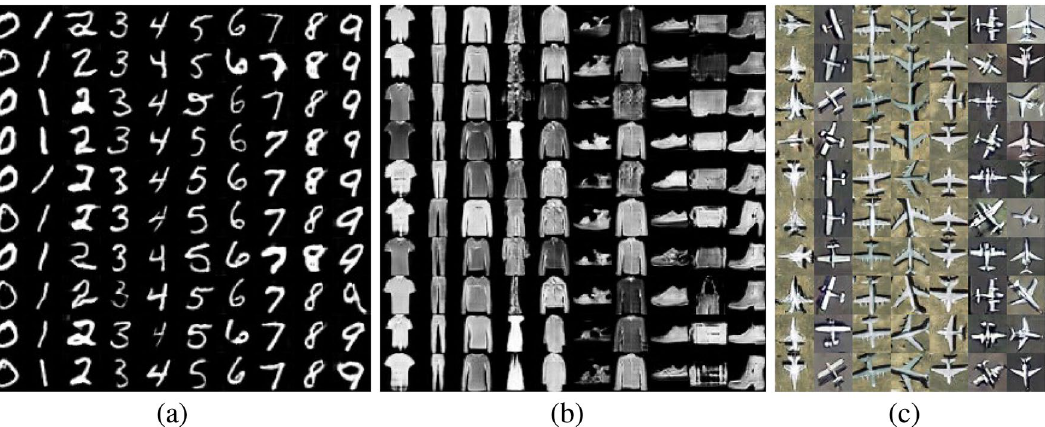
Figure 5. Examples of generated samples of AWCA-GAN on three datasets: ( a ) OPT_Aircraft-7; ( b ) MNIST; and ( c ) Fashion-MNIST.